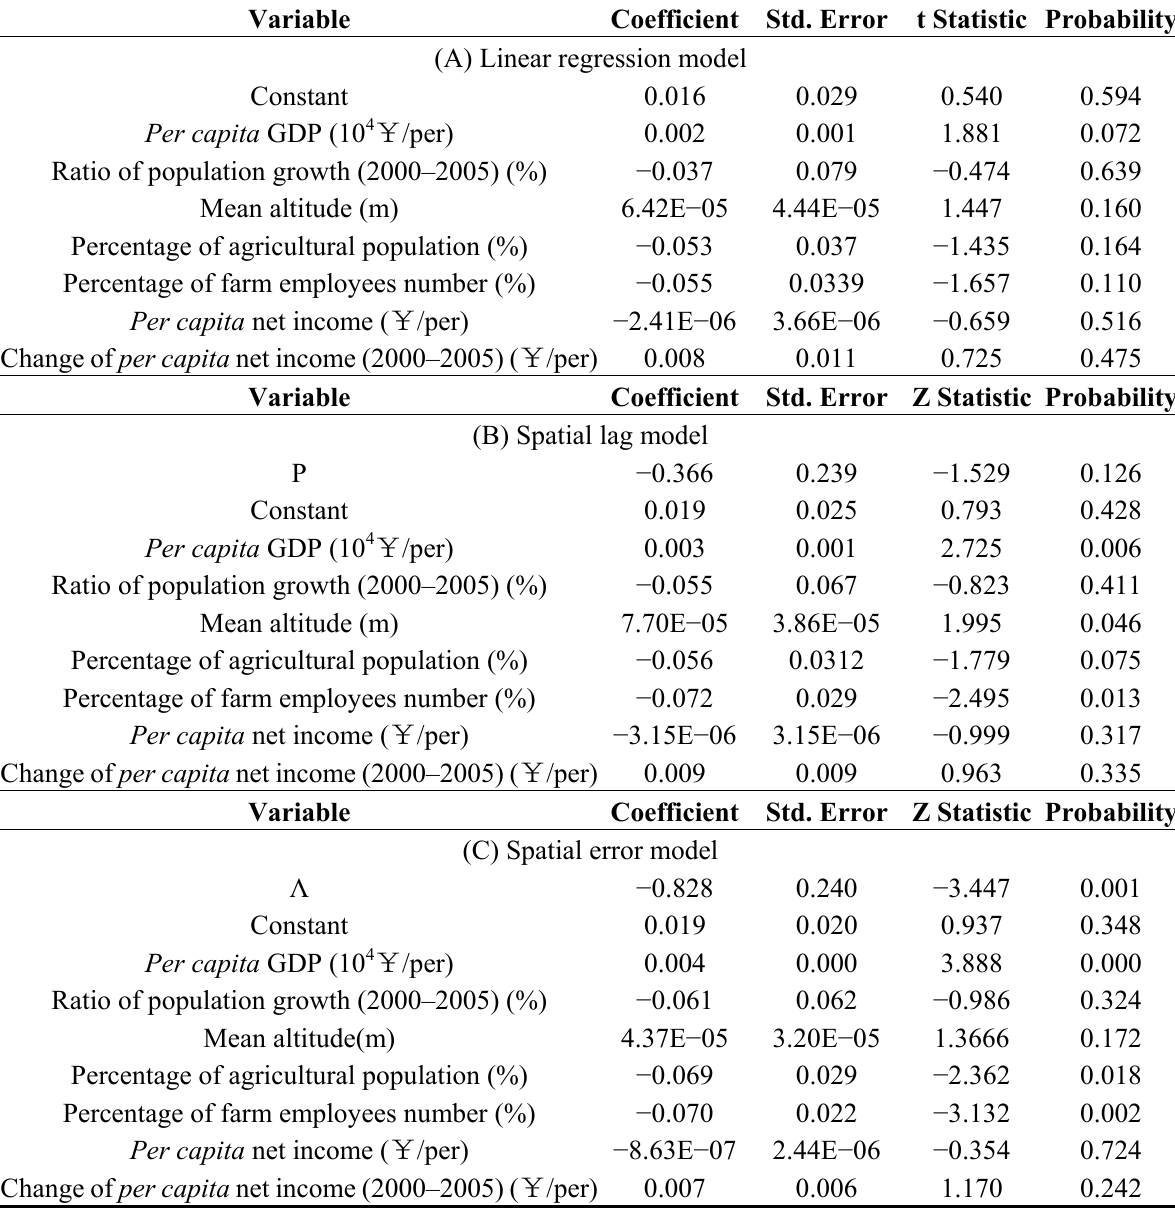
Table 6. Parameters of the three regression models for ecological land change in the Poyang Lake Eco-economic Zone during 2000 to